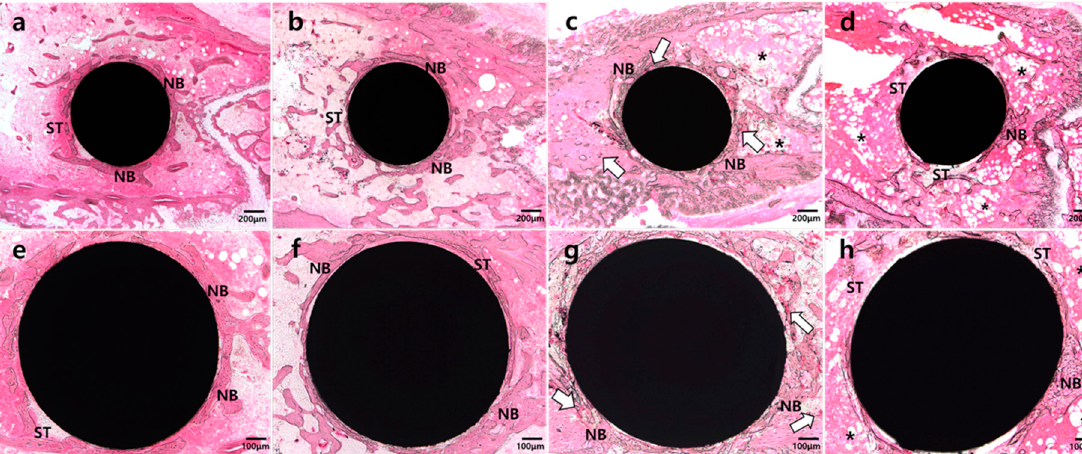
Figure 1. Representative images of undecalcified specimens of four groups. ( a ) and ( e ): Abundant and well-developed new bone (NB) formation observed around the implant in the normal mice with HIF-1 α gel (NH) group, with some soft tissue (ST) engagement observed; ( b ) and ( f ): Thin and well-defined new bone formation observed in the normal mice with placebo gel (NP) group; ( c ) and ( g ): Plentiful vascular sinusoids with red blood cells (white arrow) and newly-formed bone surrounding the implant in the diabetic mice with HIF-1 α gel (DH) group; ( d ) and ( h ): Fibrotic and adipose tissue (asterisk) surrounding the implant in the diabetic mice with placebo gel (DP) group.